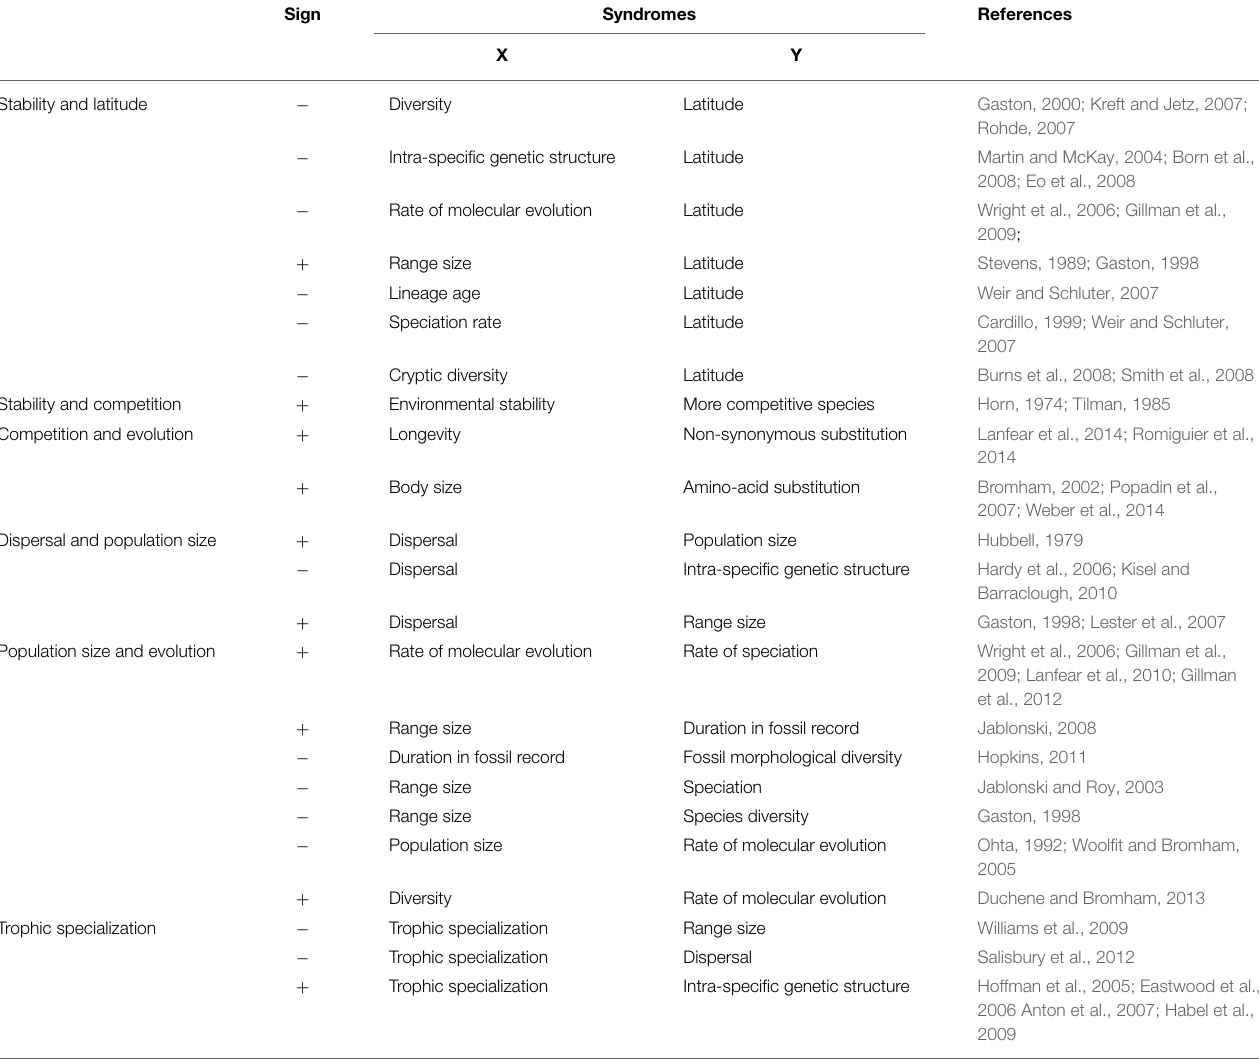
TABLE 1 | List of syndromes that provide indication of the links between competitive abilities, dispersal abilities, population sizes, and species diversification along a latitudinal